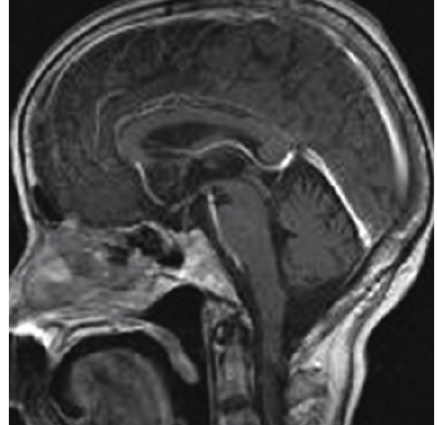
Figure 2: Sagittal Gd-enhanced brain MRI after 5-course chemotherapy shows complete disappearance of the